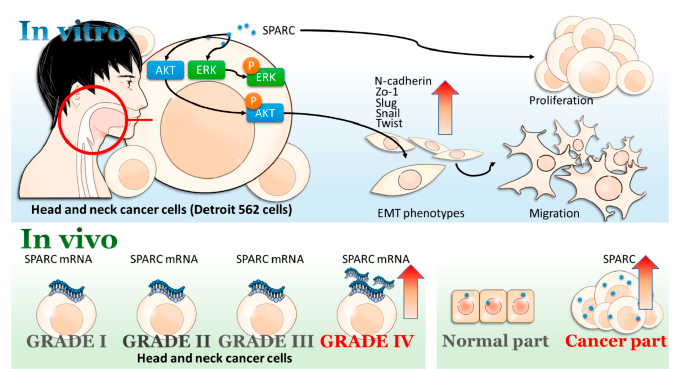
Figure 7. Scheme of proposed SPARC-induced signaling pathways in head and neck cancer.